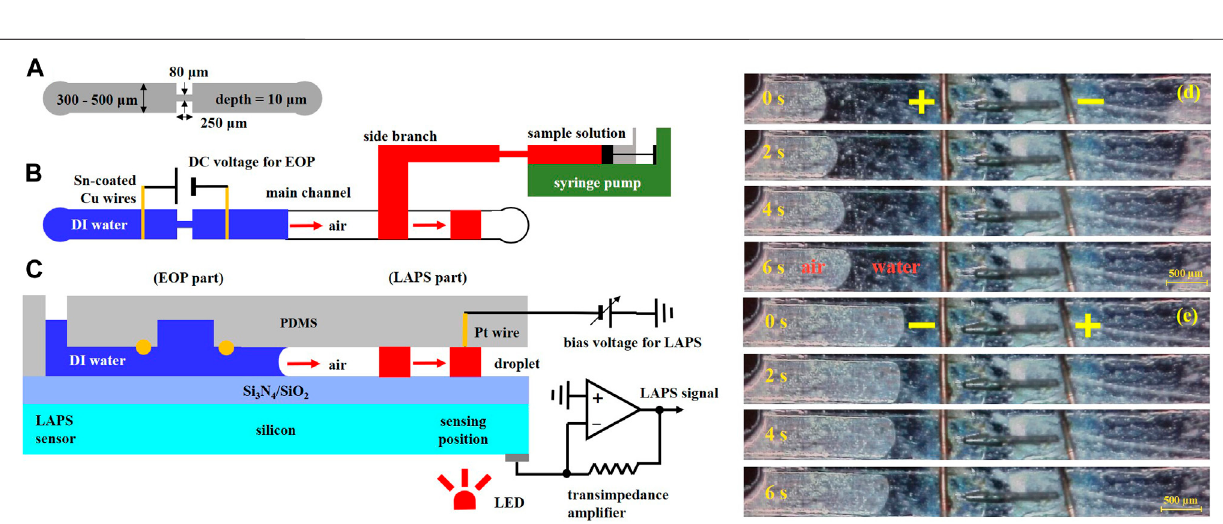
FIGURE 9 |(A) Schematic diagram of the microchannel structure and size; (B) and (C) a top view and a side view of the microchannels. The microelectrochemical analysis system includes an electroosmotic driving section and a LAPS detection section. A microdroplet is generated near the “ D" intersection of T-shaped microchannels.ThemicrodropletispumpedtothedetectionareaoftheLAPSbytheelectroosmoticmicropump,andthemicrodropletcontactswiththePtlinetoforma conduction loop to complete the detection of the microdroplet; EO fl ows in (D) right and (E) left directions (Li et al.,